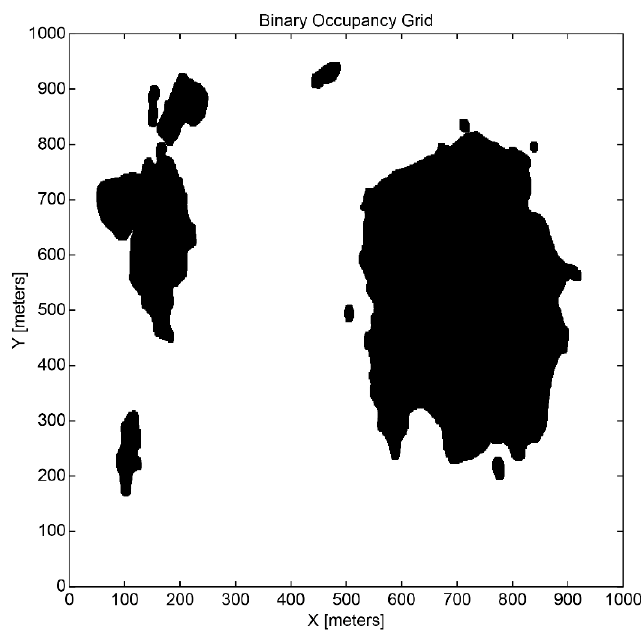
Figure 10. Binary occupancy grid map used for route